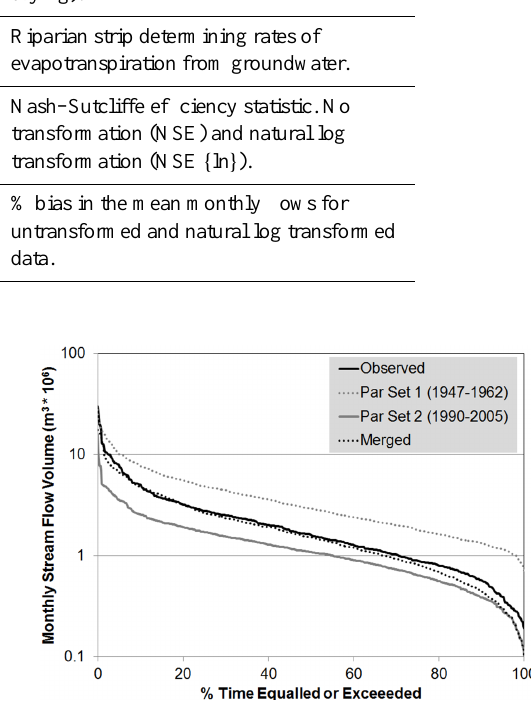
Figure 1. Flow duration curves for the NoordKaap River example based on data for 1948 to 2005, including observed, simulated using parameter set 1 (calibrated for 1947 to 1962; no afforestation) and parameter set 2 (calibrated for 1990 to 2005; 70% afforestation) and a merged simulated time series (see text for